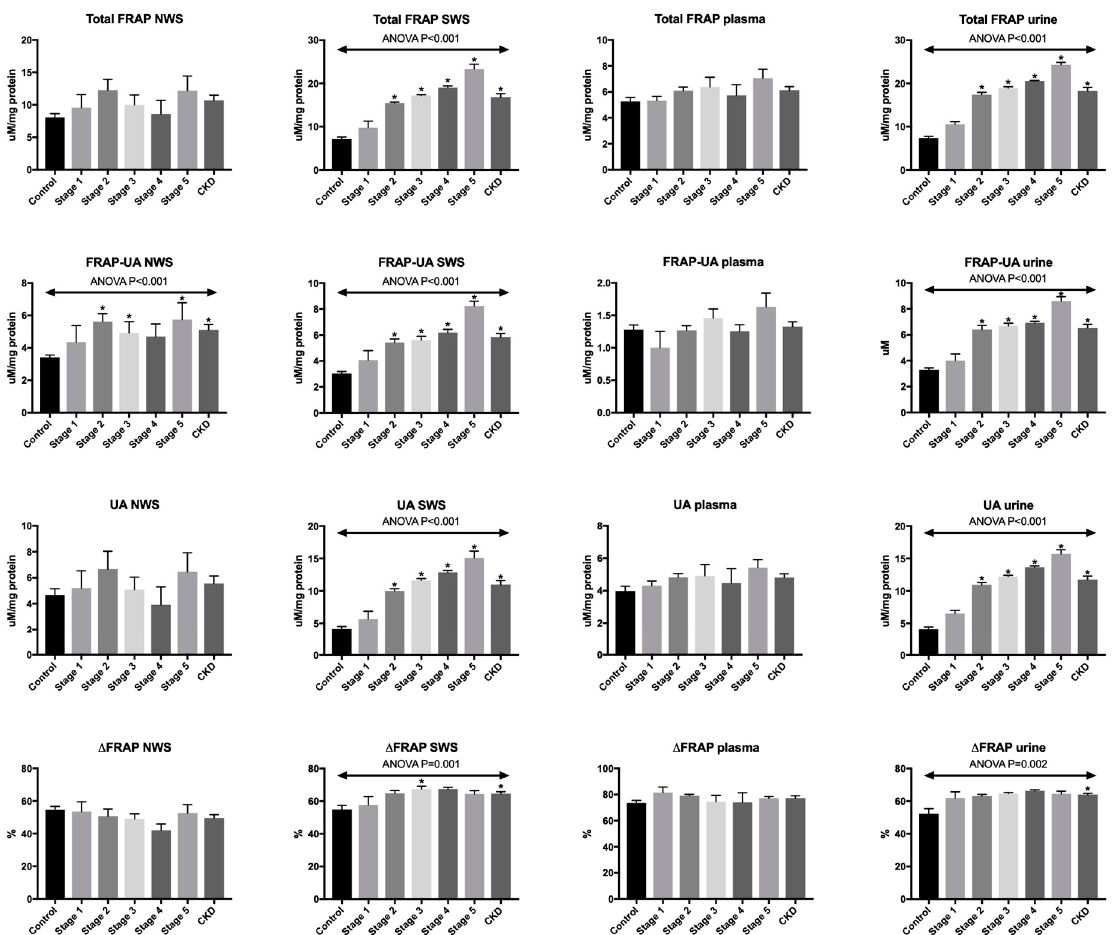
Figure 1. Total antioxidant capacity measured by FRAP in saliva, plasma and urine of children at different stages of chronic kidney disease (CKD) and healthy controls. FRAP—ferric ion reducing antioxidant parameter; FRAP-UA—UA-independent FRAP; NWS—non-stimulated whole saliva; SWS—stimulated whole saliva; UA—uric acid. * p < 0.05 vs. the control group.